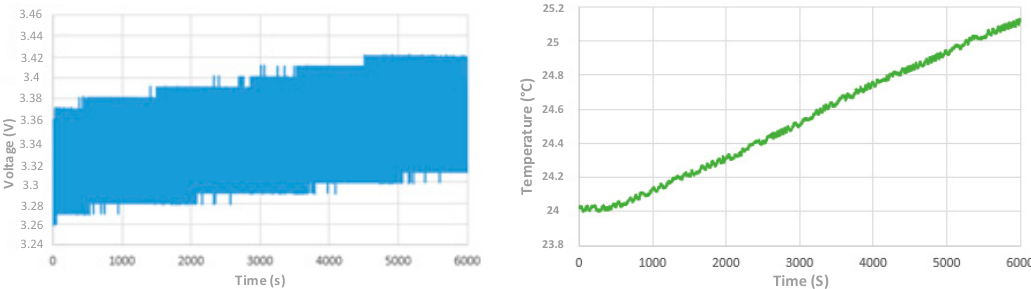
Figure 11. Time waveform of battery voltage ( left ) and its surface temperature ( right ) during last regeneration sequence.